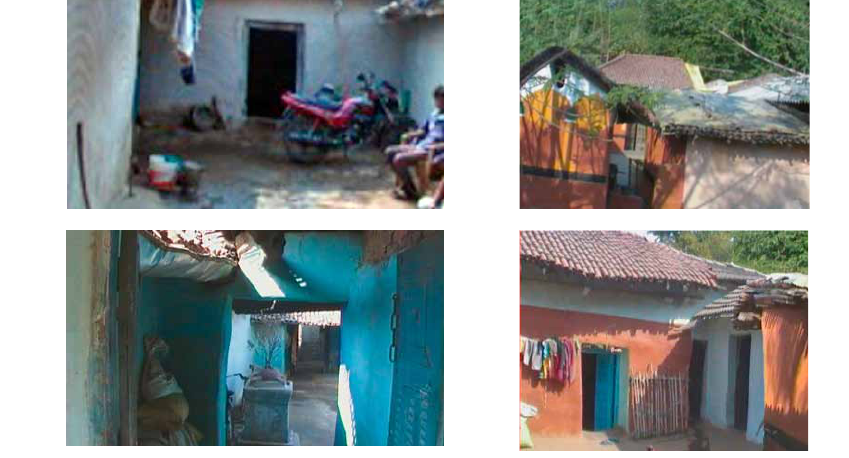
fig. 10. Square with central open courtyard